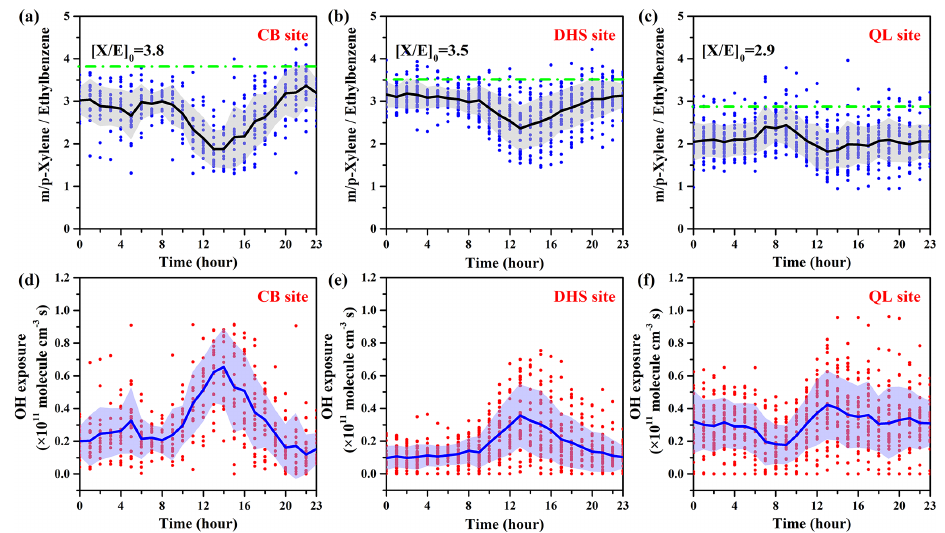
Figure 6. Diurnal variations in m/p -xylene to ethylbenzene and OH exposure at the CB, DHS, QL, and gridded sampling sites. Time is expressed in CST. The green line represents the initial emission ratio of m/p -xylene and ethylbenzene.